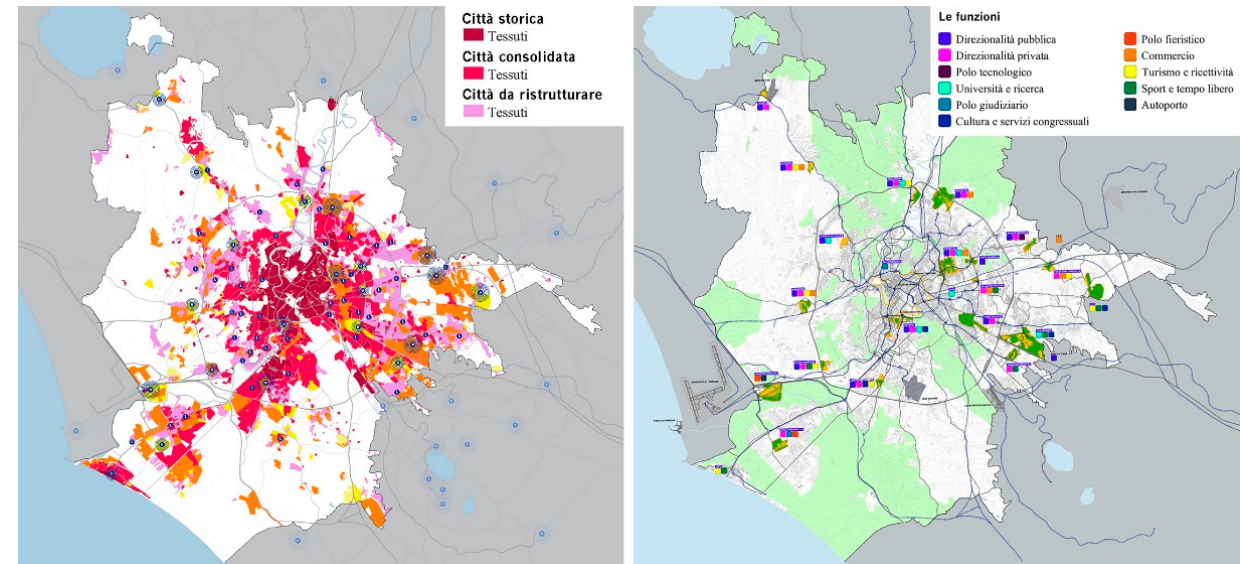
Figure 1. On the left, PRG Rome 2003, elaboration D4 Fabrics and Centrality (Source: http://www.urbanistica.comune.roma.it/images/uo_urban/prg_adottato/d4.pdf . Accessed on 22 June 2022 ). Right, PRG Rome 2003, elaboration D5 Centrality and Functions (Source: http://www.urbanistica.comune.roma.it/images/uo_urban/prg_adottato/d5.pdf. Accessed on 22 June 2022).